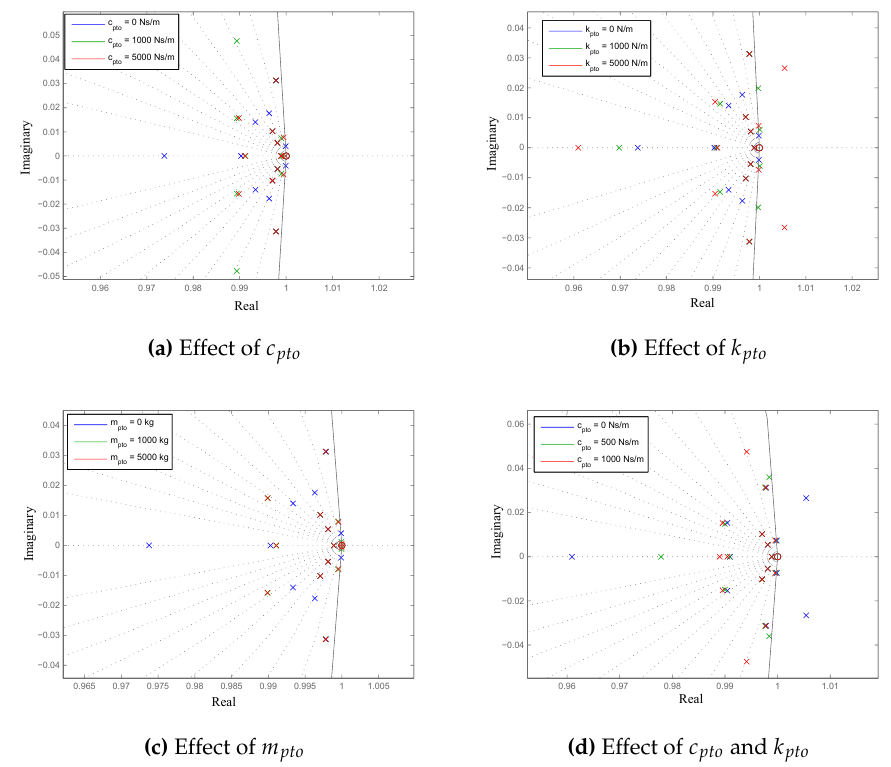
Figure 6. Zeros (O) and poles (X) of the closed loop transfer function (Figure 3) for different values of ( a ) c pto , ( b ) k pto , ( c ) m pto , and ( d ) k pto , c pto